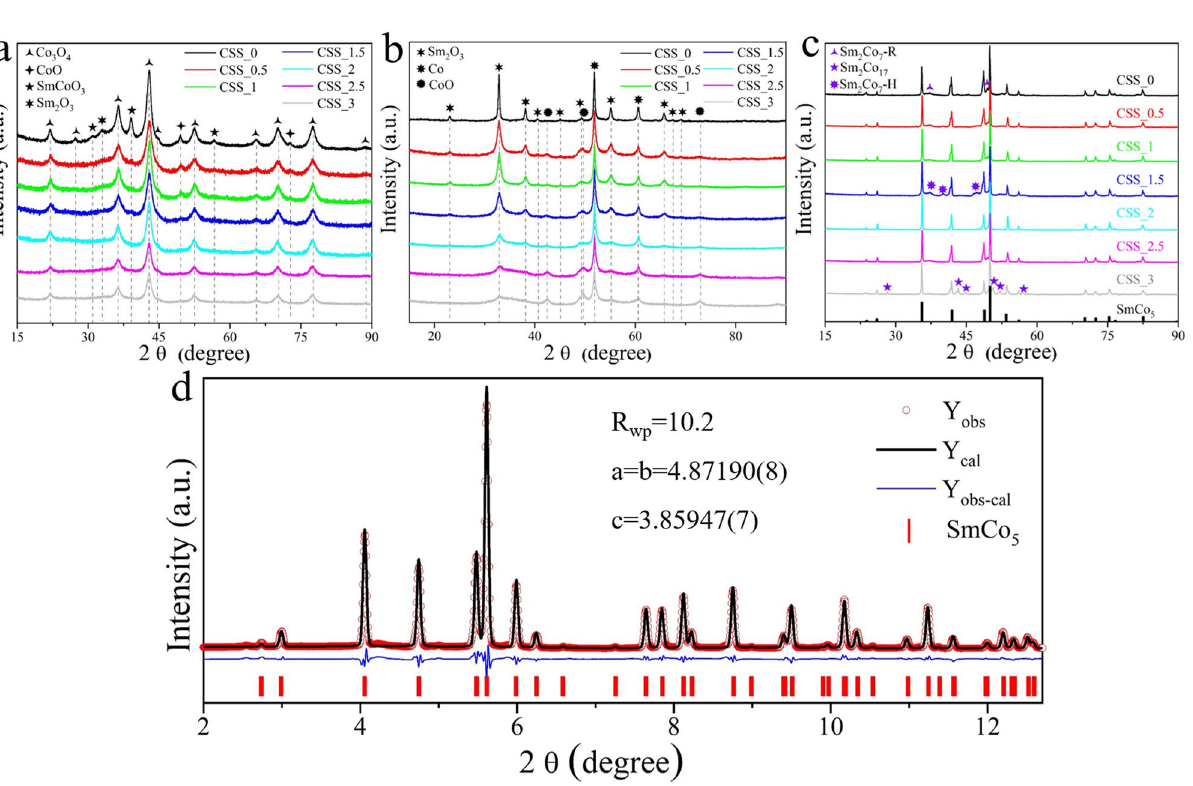
Figure 2. The PXRD patterns of ( a ) the precursors, ( b ) H 2 -precursors, and ( c ) the final products. The identification of Co pattern of CSS_2 sample collected at P02.1 beamline at Petra III, DESY (λ = 0.20714 Å). The red circles are the experimental data, while the black line is the calculated Rietveld model; the positions of the Bragg peaks of SmCo 5 phase are indicated with the red vertical lines. The blue line represents the difference between the observed and calculated intensities. Software: Origin 2016, www.origi